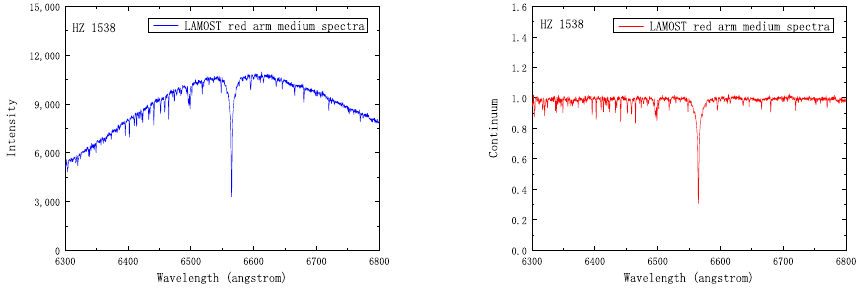
Figure 3. Observed medium-resolution LAMOST spectra ( left ) and its normalised spectrum ( right